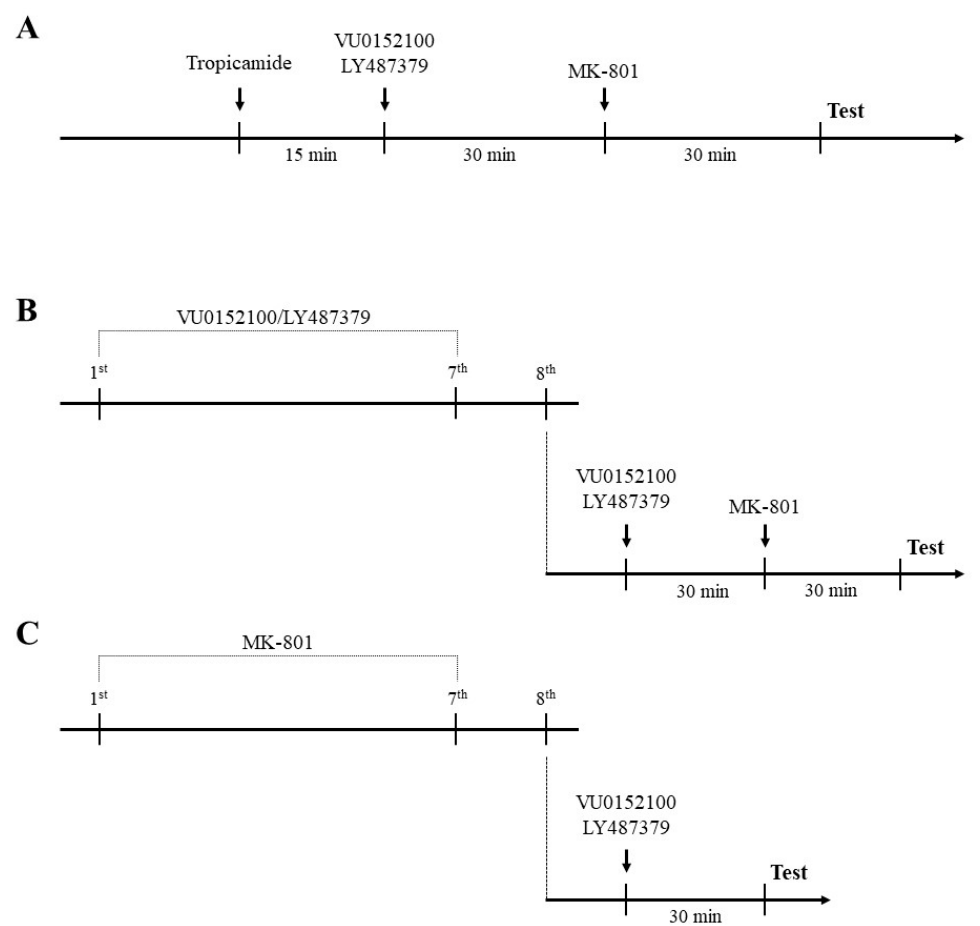
Figure 1. Schematic representation of the experiments performed in this study. ( A ) Acute administration of investigated compounds and MK-801. ( B ) Prolonged administration of investigated compounds and acute administration of MK-801. ( C ) Prolonged administration of MK-801 and acute administration of investigated compounds.